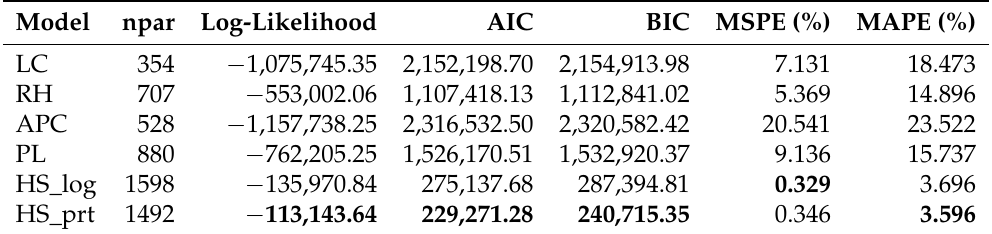
Table 5. Results of the quantitative tests for well-known stochastic mortality models against HS_prt for E&W